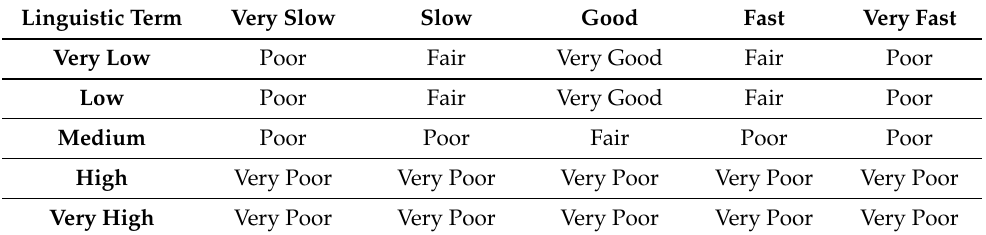
Table 4. Summary of rules used for Case Study